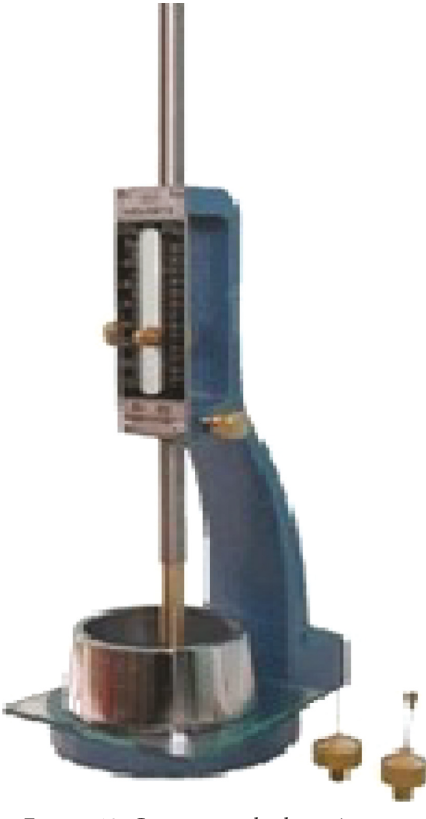
Figure 10: Cement standard consistency. Table 4: Compressive strength, standard consistency, and minimal water requirement.